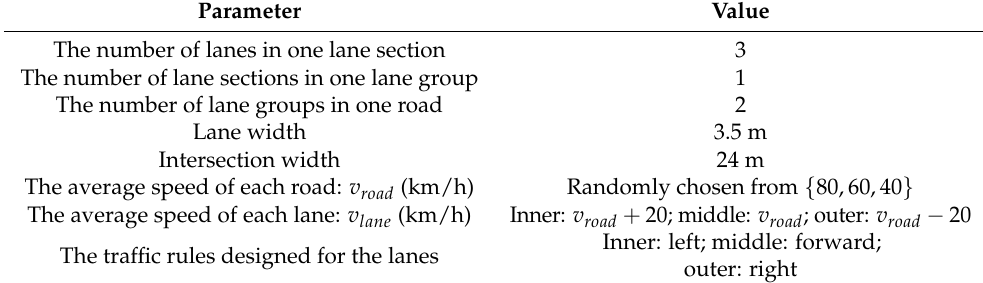
Figure 10. An intersection and corresponding virtual lanes. ( a ) An intersection and four connecting roads are shown. ( b ) The virtual lanes in the intersection shown in ( a ) are displayed.